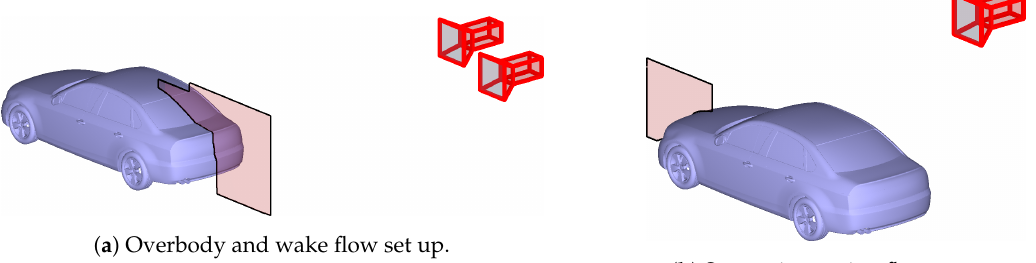
Figure 9. PIV Camera set up and approximate fields of view for the Y = 0 m plane in the wake ( a ) and the stagnation ( b ) regions.